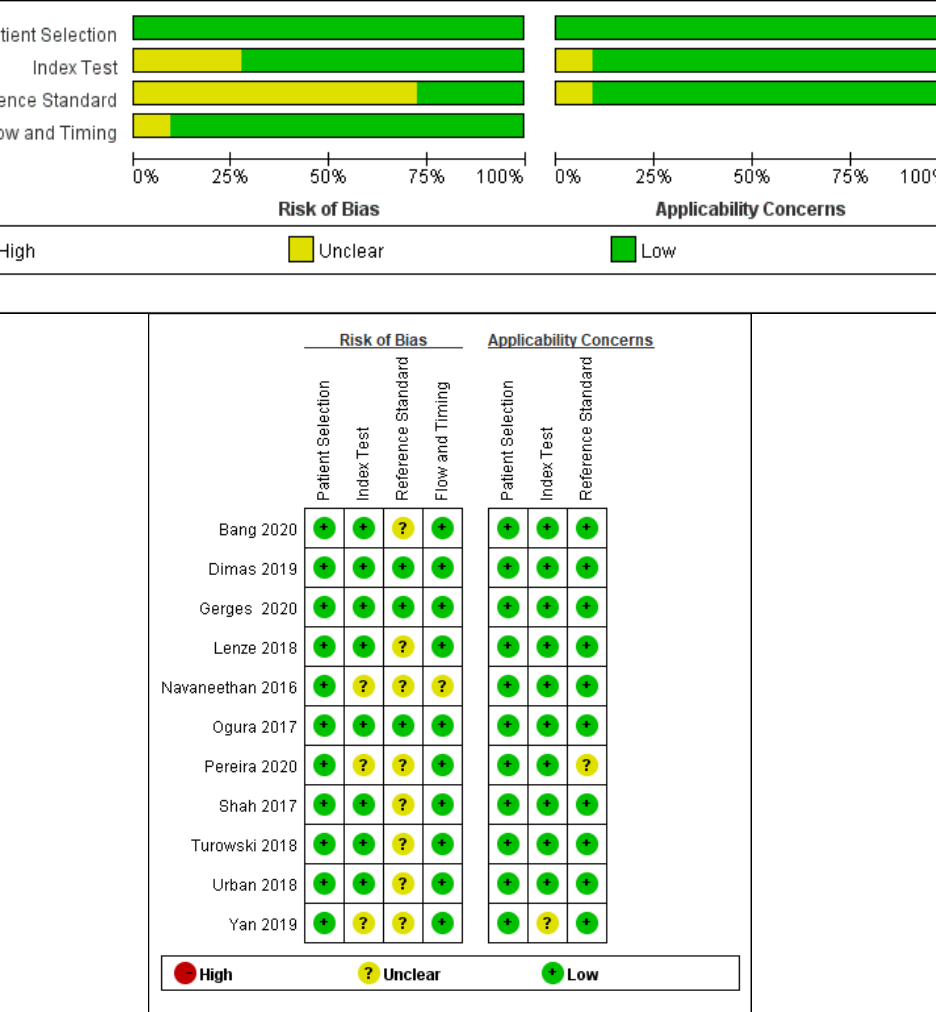
Figure 2. Evaluation of risk of bias and quality of the included studies by the Quality Assessment of Studies of Diagnostic Accuracy Included in Systematic Reviews (QUADAS-2).